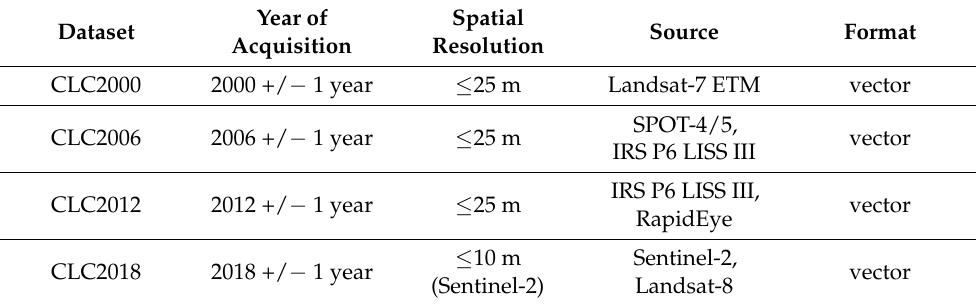
Table 1. Description of the source data for interpretation of land cover at a scale 1:100,000 (CORINE Land Cover). Year of Spatial Source Format Dataset Acquisition Resolution CLC2000 2000 +/ − 1 year ≤ 25 m Landsat-7 ETM vector SPOT-4/5, vector CLC2006 2006 +/ − 1 year ≤ 25 m IRS P6 LISS III CLC2012